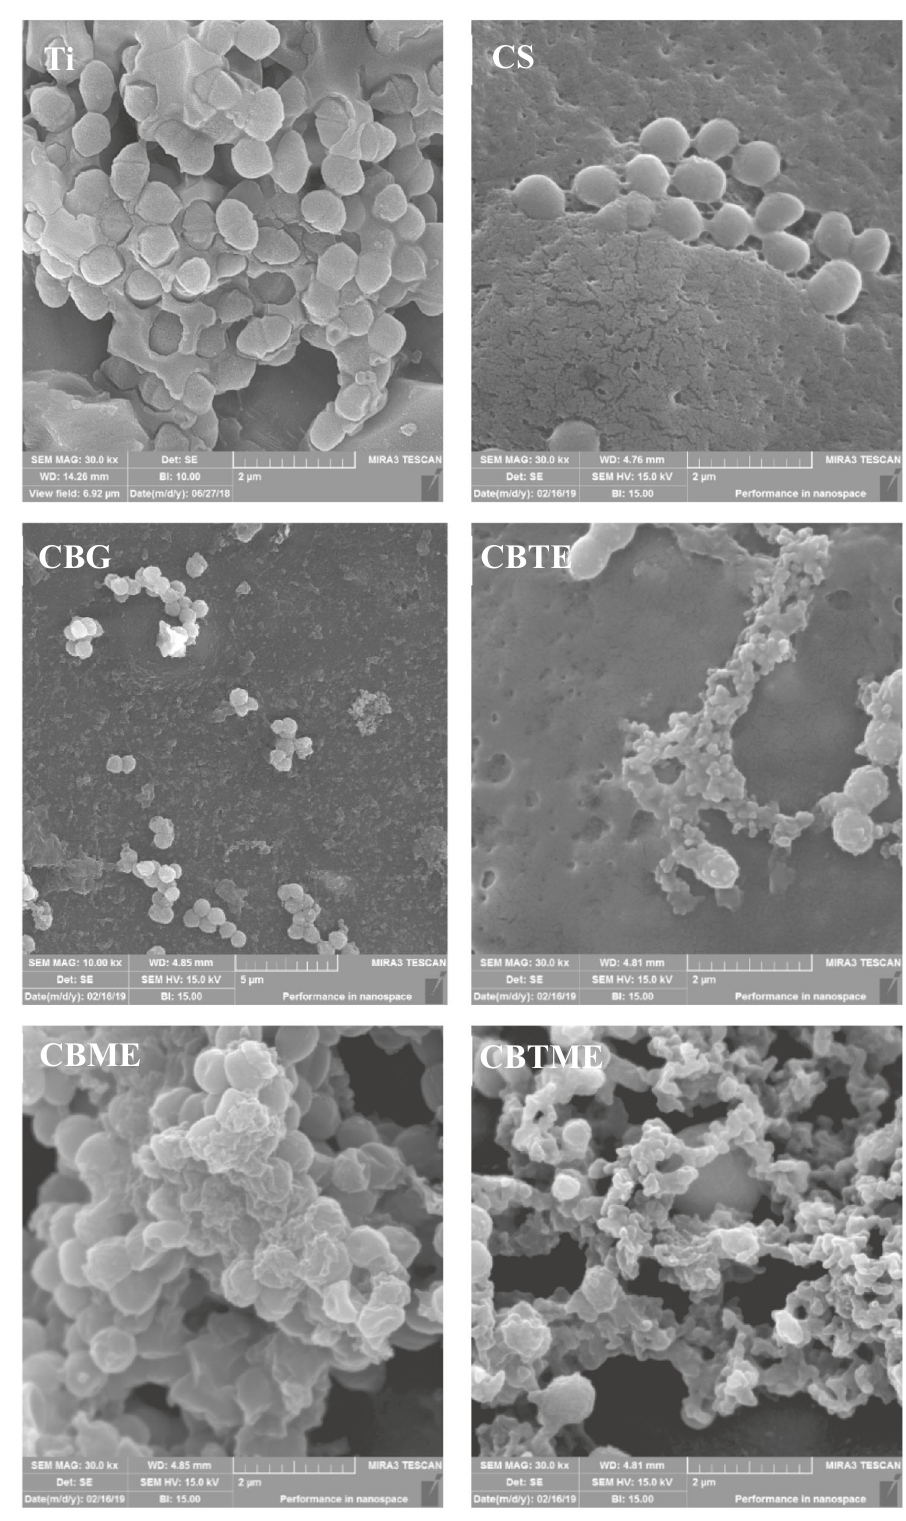
Fig. 8 SEM images of MRSA bacteria on experimental groups after incubation for 6 h (SEM magni fi cation in all images is 30.0